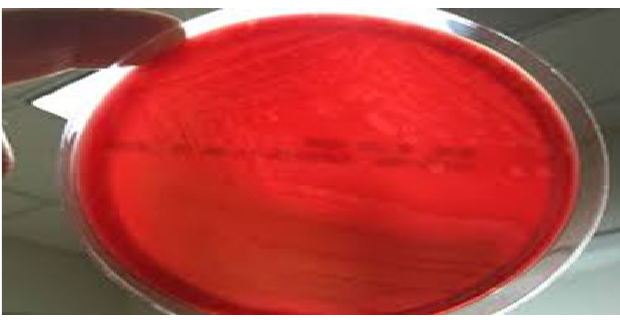
Fig. 8 Hemolysis on blood agar 6. Incubation period: